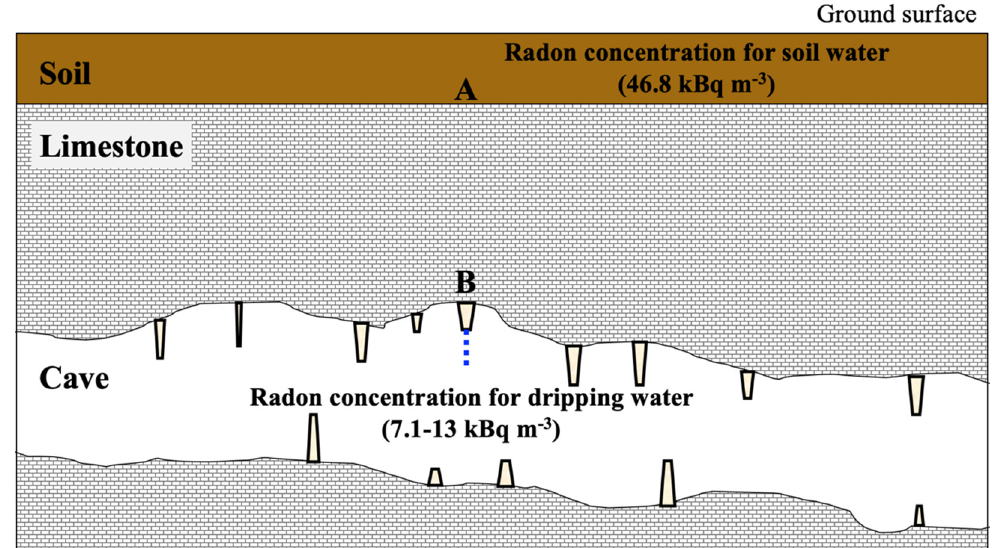
Figure 6. Schematic of the Gyokusendo cave profile, where A is the boundary between the soil and the limestone, and B is the target straw stalactite.